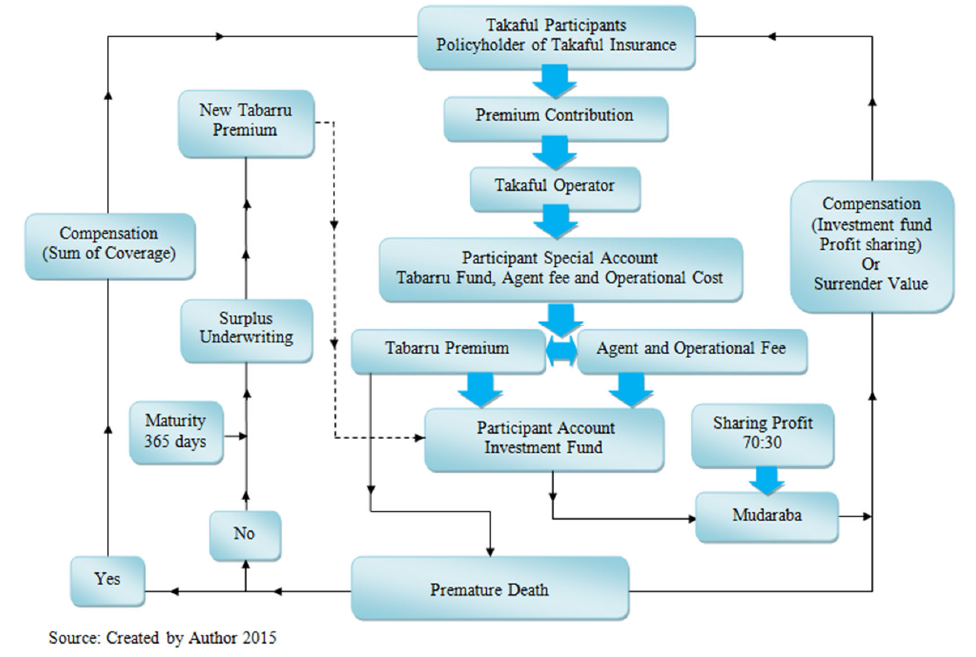
Fig. 1. A New Modeling Premium for the Takaful Business